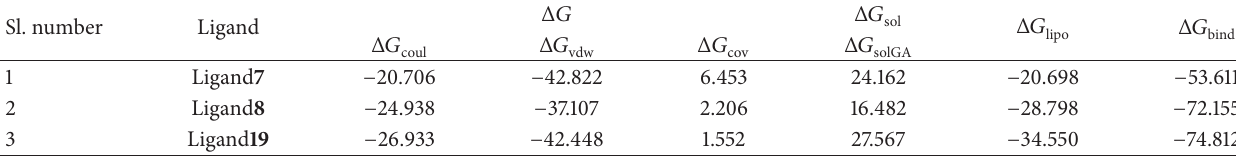
Table 4: Binding free energies derived from MM-GBSA calculations using single protein-ligand complexes (unit: kcal/mol). Sl. number